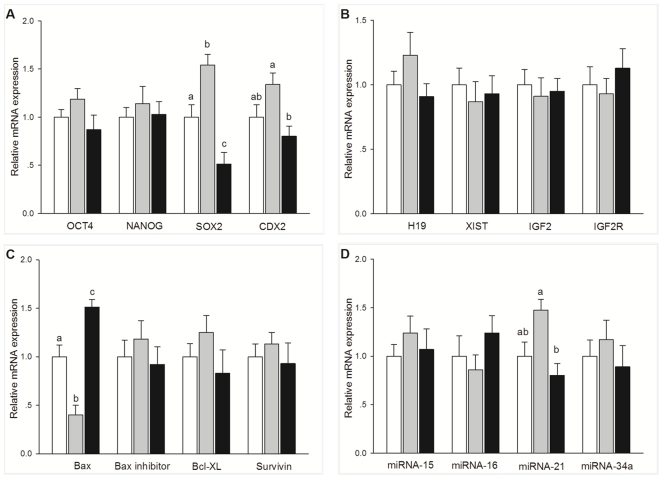
Relative abundance of apoptosis and development-related genes.Relative expression levels of development related genes (A), imprinted genes (B), apoptosis related genes (C), and microRNA (D) in single day 7 control (open bars), BCB+ (gray bars), and BCB− (black bars) blastocysts assayed by Quantitative real-time PCR and TaqMan RT-PCR. Values with different superscripts differ significantly (P<0.05); n = 5–8.